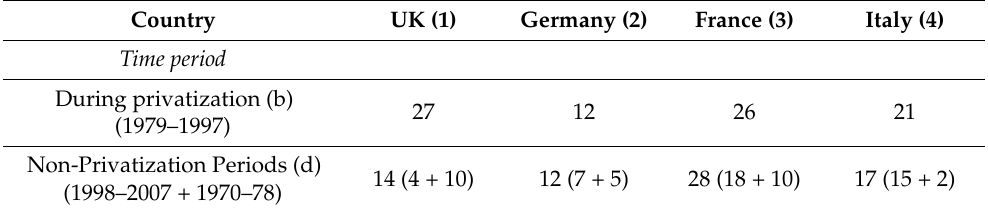
Table A1. Robustness test for Table 1 Total and per Year Number of Multi-fatality Disasters, 1970–2007. Country